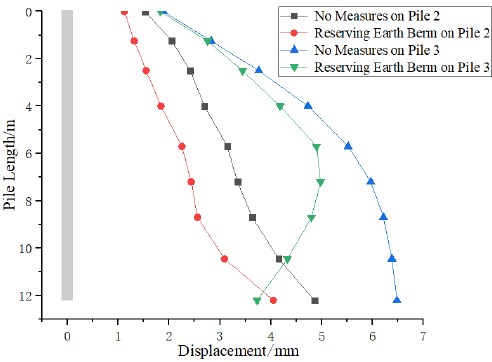
( b ) Figure 13. Comparison curve of thickness effect of grouting reinforcement with H = 12.2 m: ( a ) pile Z2; ( b ) pile Z3. 4.1.3. Influence of Excavation Earth Berm The reserved earth berm comprised undisturbed soil at the four corners of the foun- dation pit. In the calculation, the range of counter pressure soil is 8 m long in the longitu- dinal direction, 2 m high along the foundation pit, and 6 m wide in the transverse direction. Figure 14 shows a comparison curve of the horizontal displacement of piles Z2 and Z3